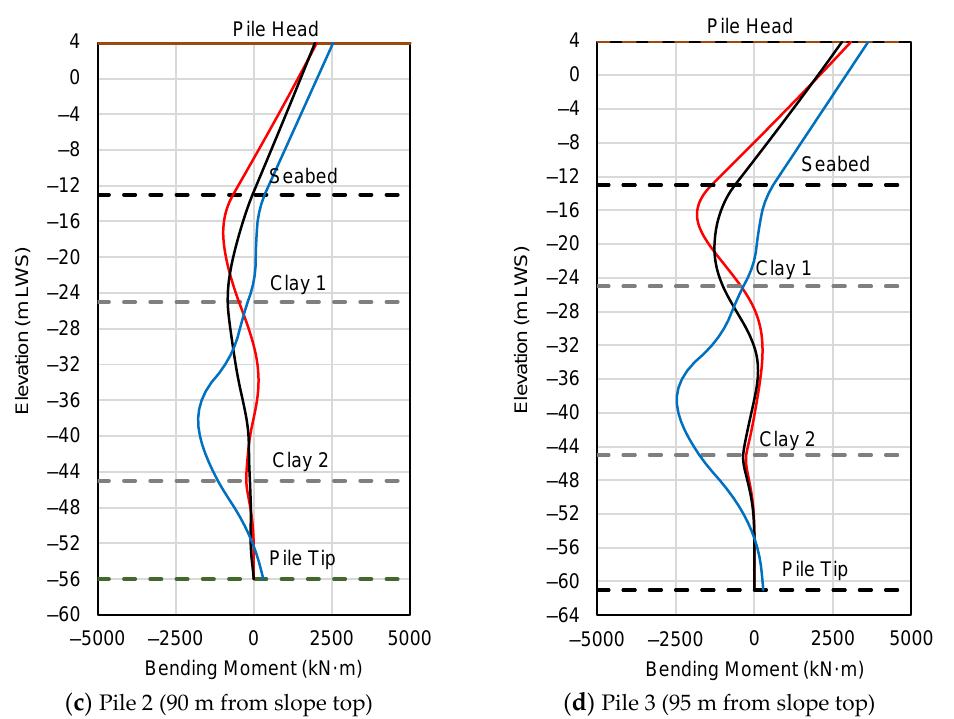
Figure 16. Bending moment distribution of the PSW considering the inertial and kinematic forces due to the TE waveform (Scenario 2).